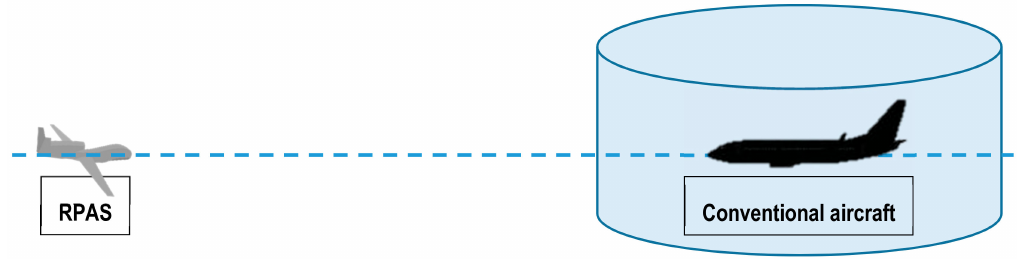
Figure 1. Conflict-geometry for a remotely-piloted aircraft system (RPAS) and a conventional aircraft flying in opposite directions. The cylinder represents the safety volume of the conventional